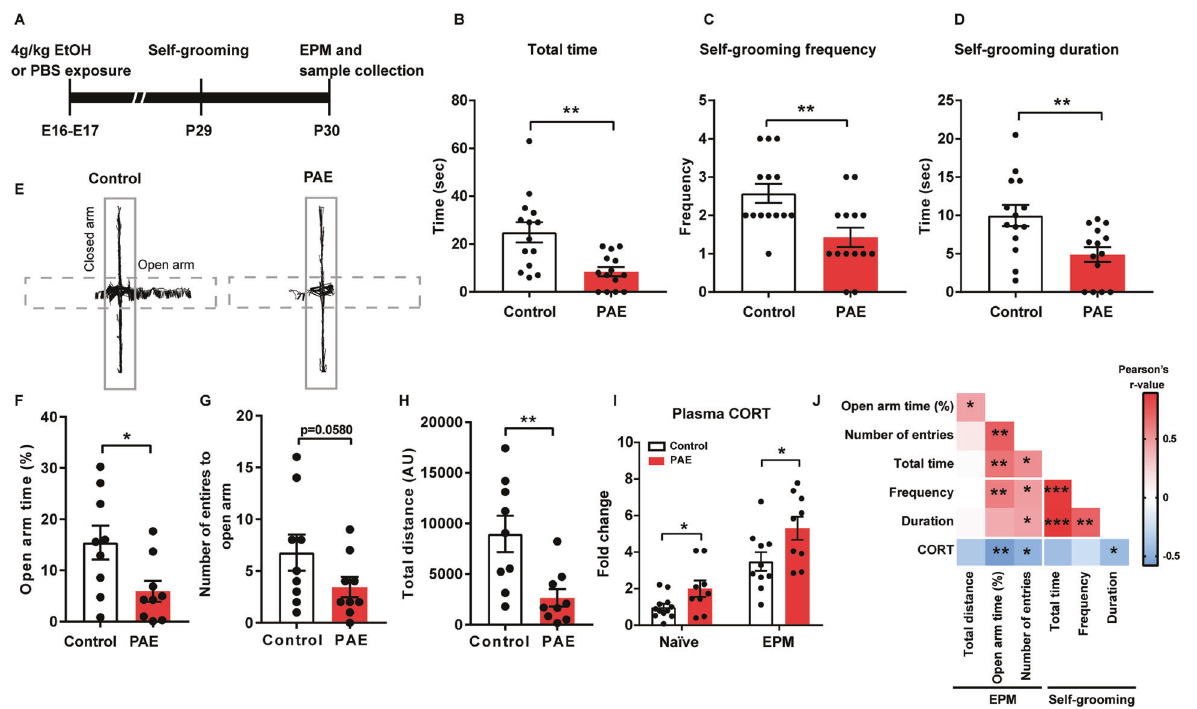
Fig. 1 PAE mice show increased anxiety and corticosterone in the plasma. A Experimental timeline. B – D PAE mice show a signi fi cant decrease in total time ( B , p = 0.0015), frequency ( C , p = 0.0034), and duration (D, p = 0.0057) of self-grooming compared to control mice. n = 14 per group. E Representative images of line tracks generated by MouBeat ImageJ plug-in from a recording of a mouse in an EPM test. Dashed and solid boxes outline open and closed arms, respectively. F – H Time in open arm ( F , p = 0.0259), the number of entries to open arm ( G , p = 0.0580), and total travel distance ( H , p = 0.0059) are signi fi cantly reduced in the PAE mice. n = 9 per group. I Fold change of the plasma corticosterone (CORT) concentration was compared to the naïve control group (control mice that were not placed in any behavior tests). In both naïve conditions and 60 min post EPM test, PAE mice show a signi fi cant increase in plasma CORT level compared to the control mice ( p = 0.0332 and p = 0.0192, respectively). Naïve: Control n = 12, PAE n = 9, EPM: Control n = 10, PAE n = 9. J A correlation matrix is presented to show associations between variables of behavior tests (self-grooming and EPM) and concentrations of plasma CORT. *,**,*** = p < 0.05, 0.01, 0.001 by one-tailed Pearson ’ s correlation coef fi cient. B – D , F – I Graphs represent mean ± SEM, and each dot represents an individual animal. Unpaired two-tailed Student ’ s t -test was used for statistical analyses. *,** p < 0.05,